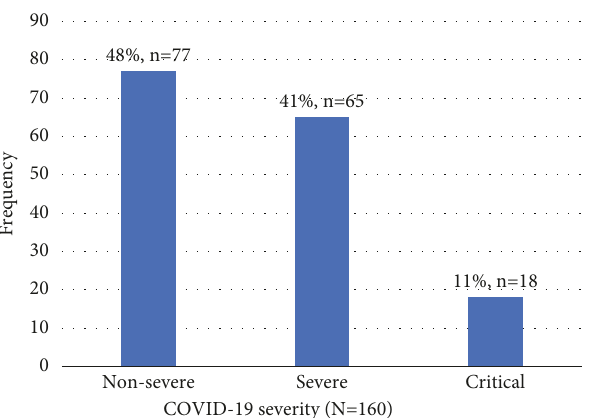
Figure 5: COVID-19 severity among the participants.